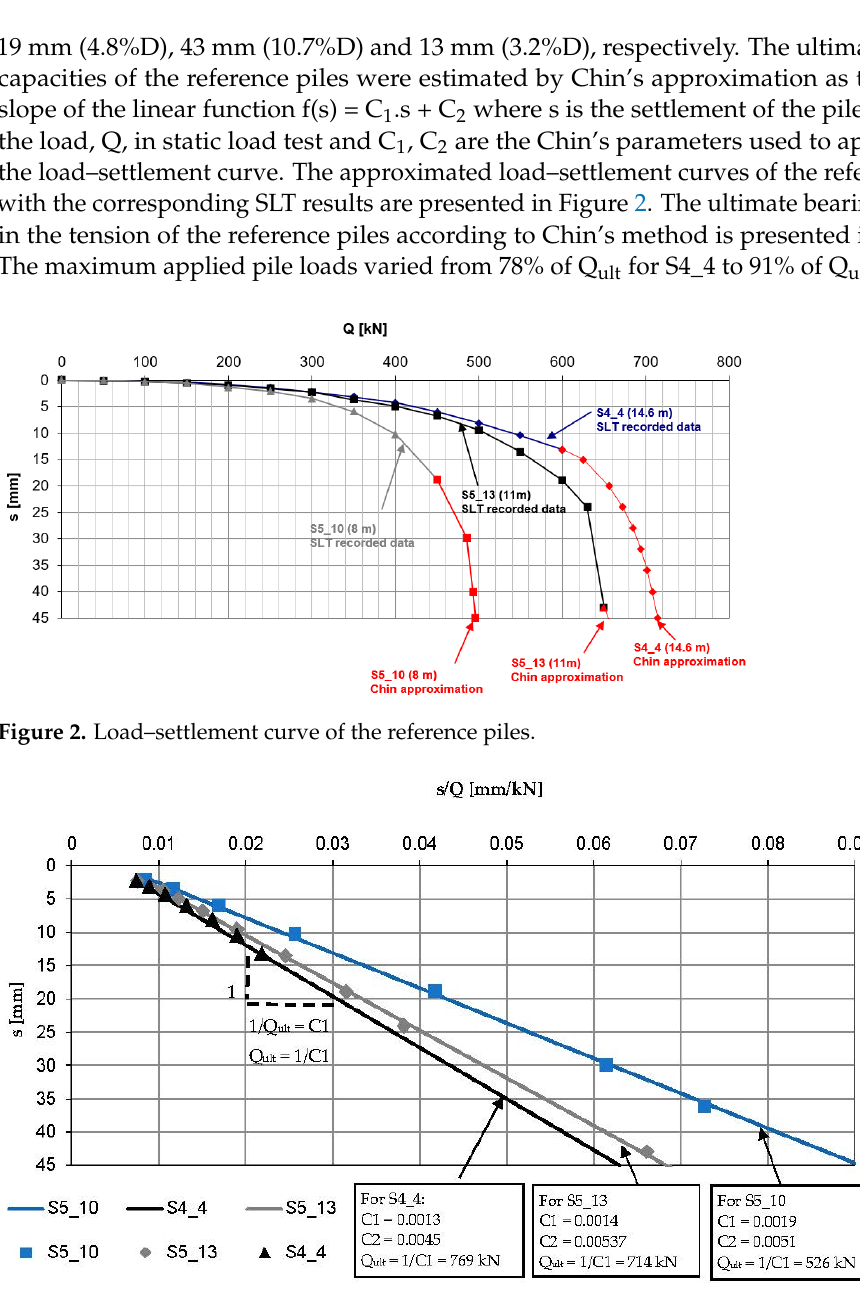
Figure 3. Ultimate bearing capacity in the tension of the reference piles according to Chin’s